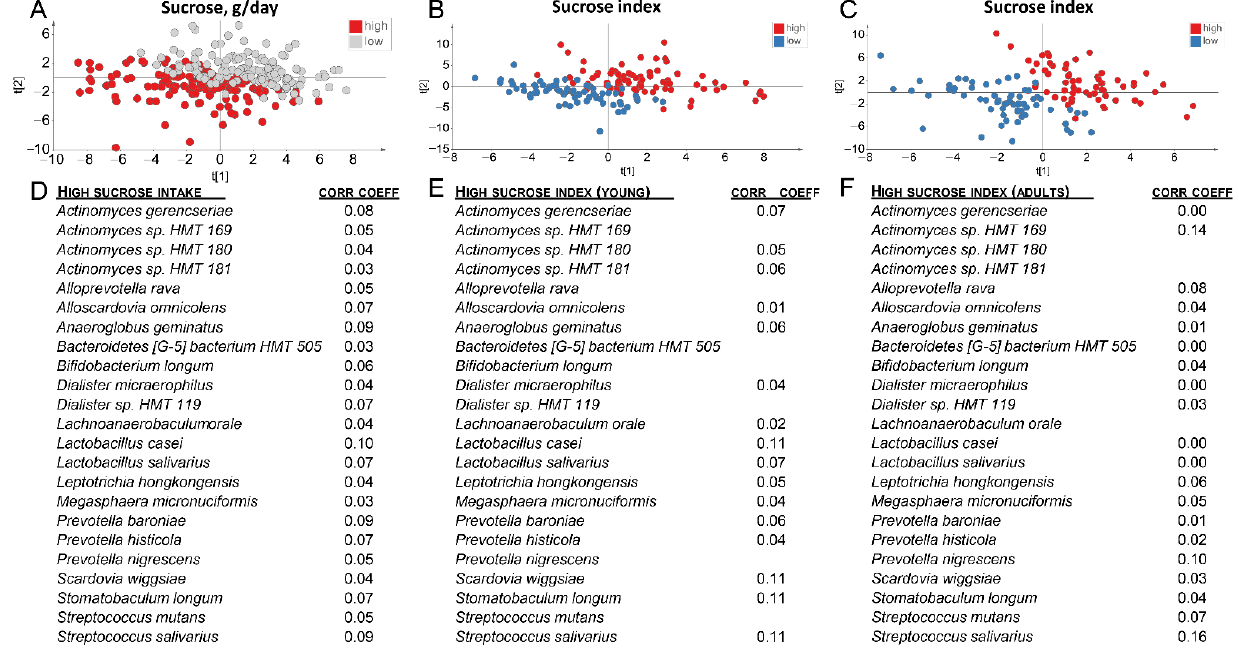
Figure 6. ( A – C ) PCA scatter plots showing separation of participants in the highest versus lowest tertile from ( A ) reported daily sucrose intake among all participants, and ( B ) sucrose index distributions in the younger group and ( C ) sucrose index distributions in the older group. ( D ) Bacterial species with a significant impact in the separation seen in ( A ), and ( E , F ) in the separation seen in ( B , C ), respectively. The models included abundances of the 465 saliva identified species and phylotypes as the independent variable block (X), and the independent variables in the PLS models were tertile classification of reported daily sucrose intake and sucrose index, respectively. Species lacking a correlation coefficient were not influential in the model.